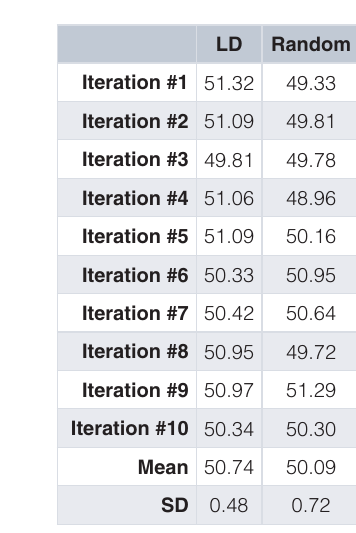
Table 2. Results of the classifications for the non- stimulated participants.